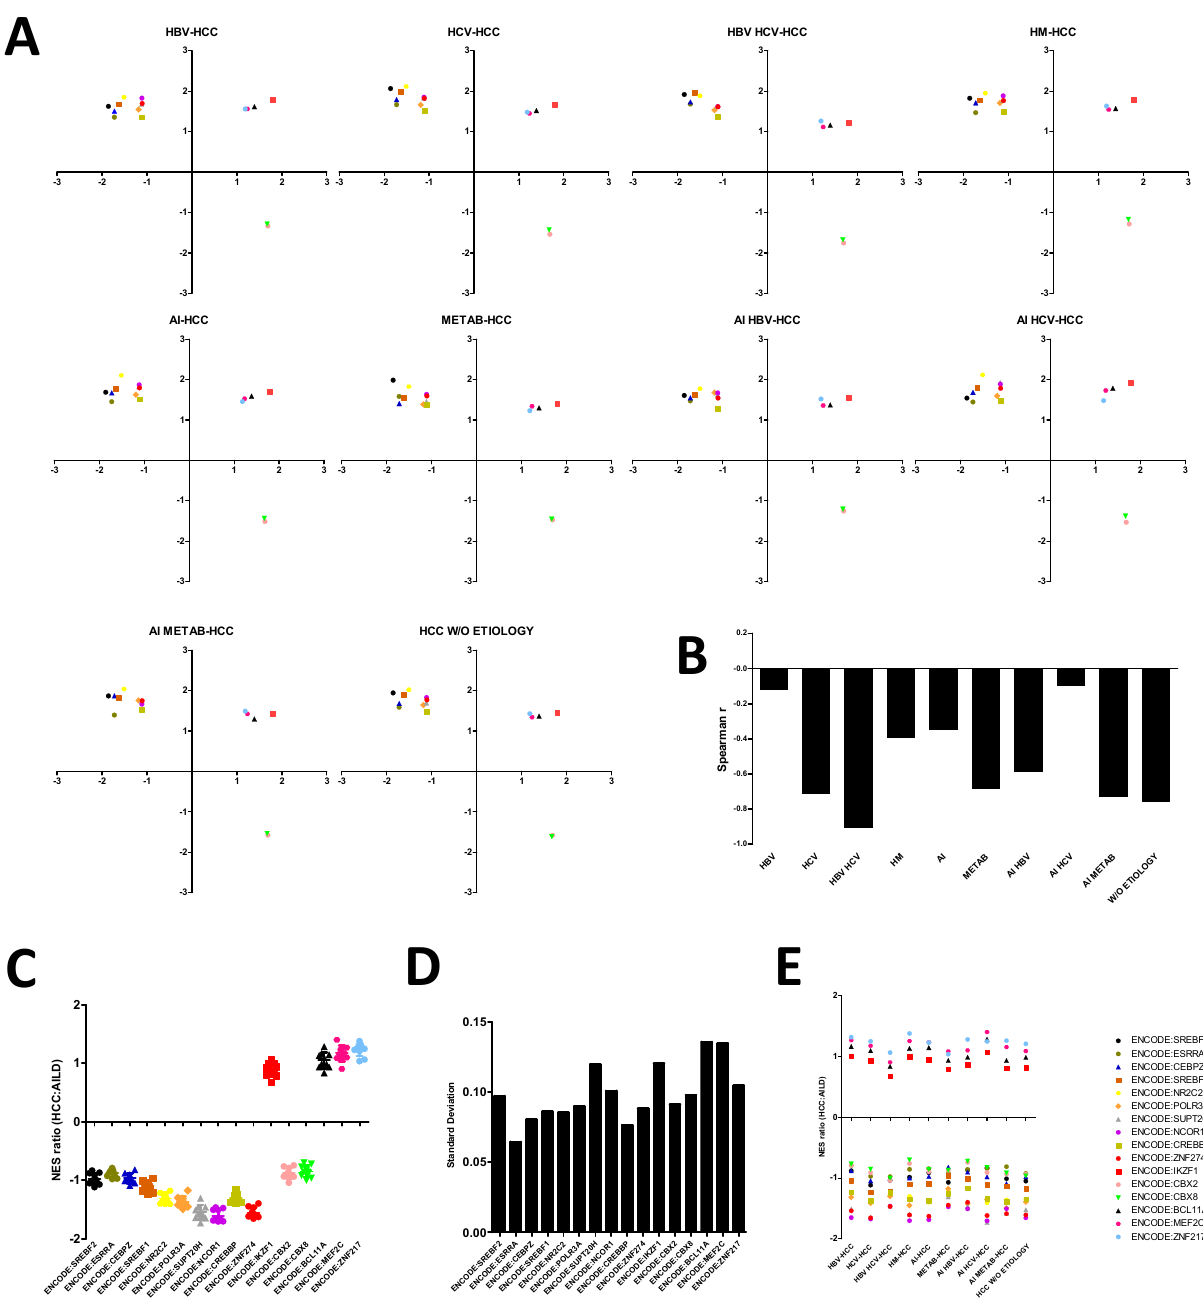
Figure 3. AILD associated HCC signatures across different etiologies. ( A ) 2D scatter plots depicting the enrichment scores of transcription factor modules along AILD vs. healthy liver (x axis) and HCC vs. non tumor liver (y axis) comparisons for different HCC etiology groups. Enrichment scores were obtained following GSEA against “TF.Target.ENCODE” database on iDEP.91. Moving rightwards along the x axis indicates increased expression in AILDs and moving upwards along the y axis indicates increased expression in HCC. ( B ) Spearman rank correlation coefficient between AILD and HCC for each etiology group. ( C ) distribution of NES ratio between AILD and HCC for each TF module across all etiology groups. ( D ) standard deviation of NES ratio distributions of TF modules. ( E ) dot plot displaying NES ratio of each TF module for each etiology group. The color and signs of each transcription factor module (for A , C , E ) are shown at the right side of ( E ) .